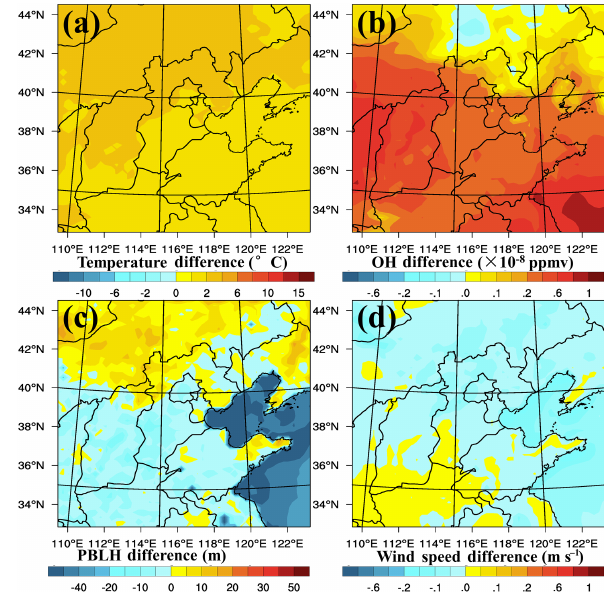
Figure 6. Monthly mean temperature difference due to perturbation in initial and boundary conditions (a) , and daily mean OH (b) , mean PBLH (c) , and mean near-surface wind speed changes (d) due to temperature increase